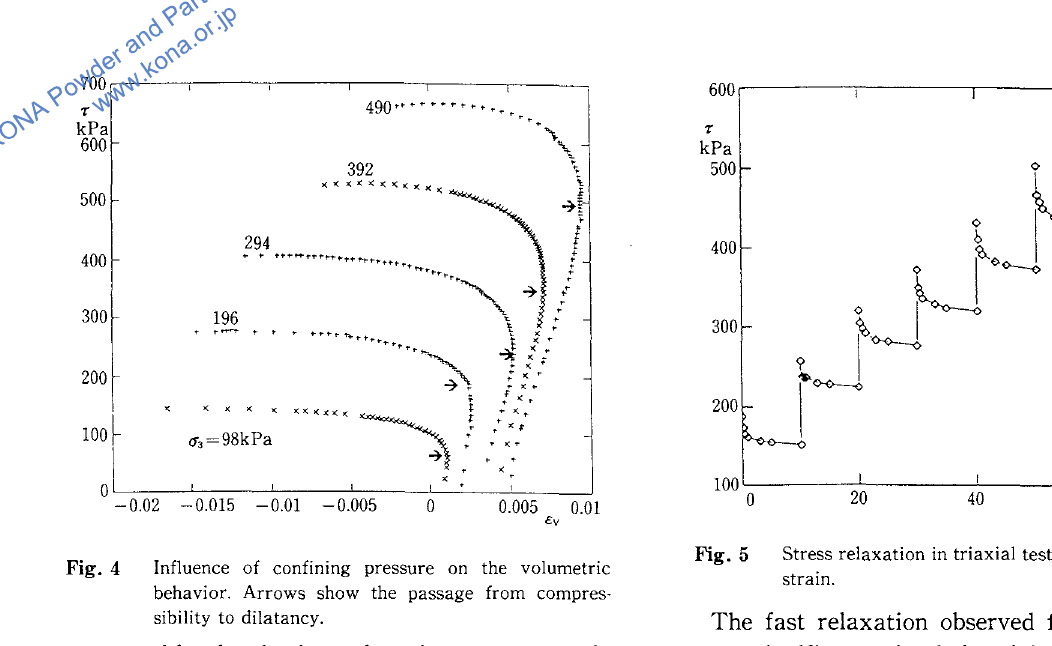
Stress relaxation in triaxial tests under constant axial strain.